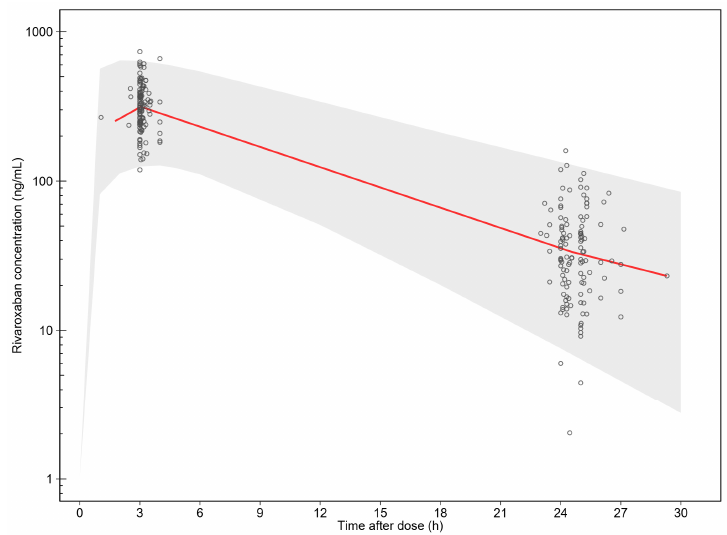
Figure 2 . The simulated 90% prediction interval from the final population pharmacokinetic model of rivaroxaban. The open circles represent the observed rivaroxaban concentrations. Solid red line represents the 50th percentile of the observations. The shaded area represents the 90% prediction interval of the simulations ( n = 1000).